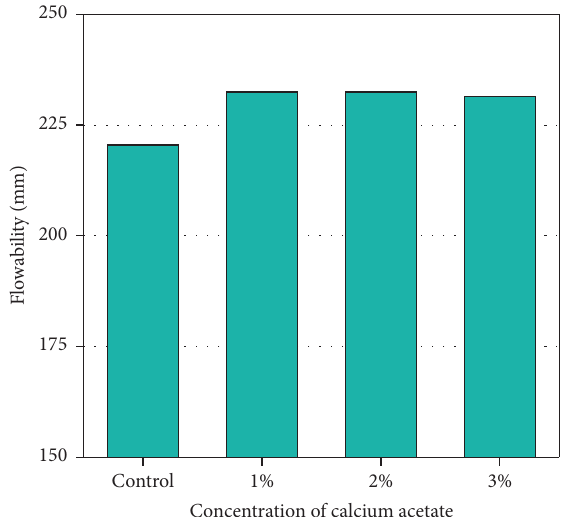
Figure 5: Effect of calcium acetate concentration on the flowability of mortar.